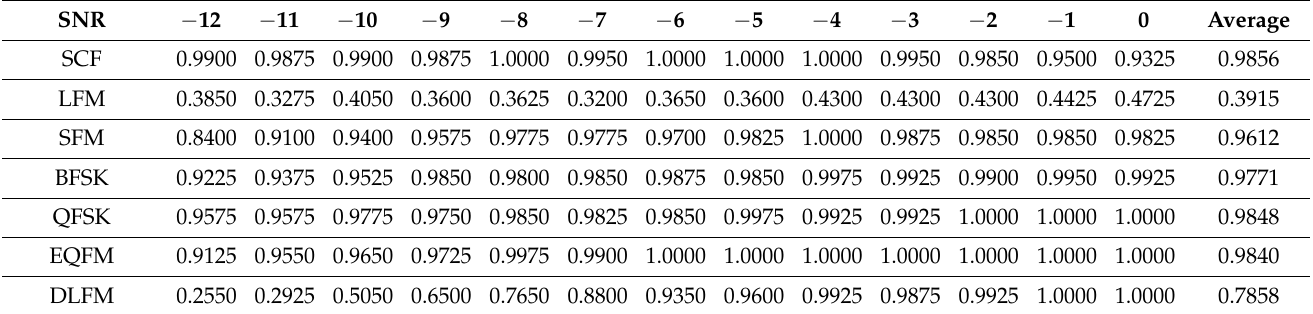
Table A17. Semi-supervised classification results with the datasets in Situation Dataset 5 without self-paced data augmentation ( T cycle = 100, NUM =